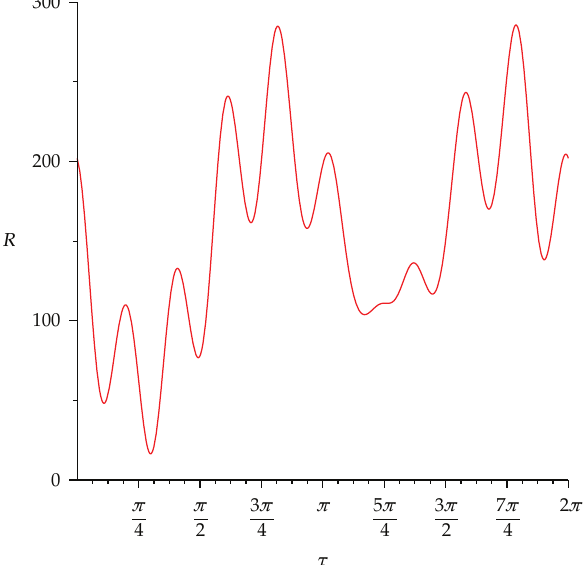
Figure 26: The evolution of the R with respect of the cosmic time τ for (cid:2) 5.9 (cid:3) .